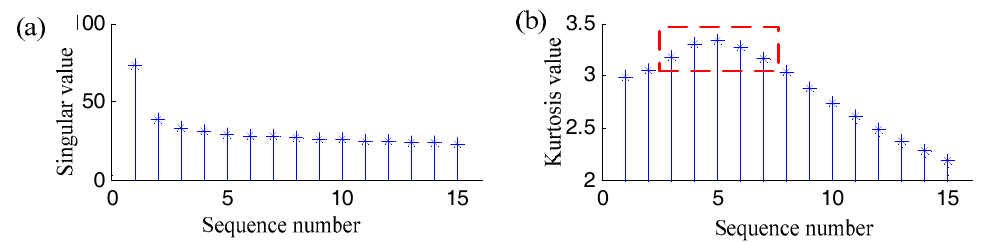
Figure 4. The singular values and kurtosis coe ffi cients corresponding to the obtained detail signals of each layer. ( a ) The singular values corresponding to the obtained detail signals of each layer. ( b ) The kurtosis coe ffi cients corresponding to the obtained detail signals of each layer.